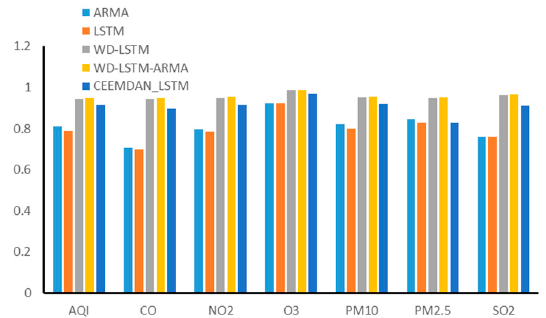
Figure 9. The RMSE histogram of prediction results for each model.